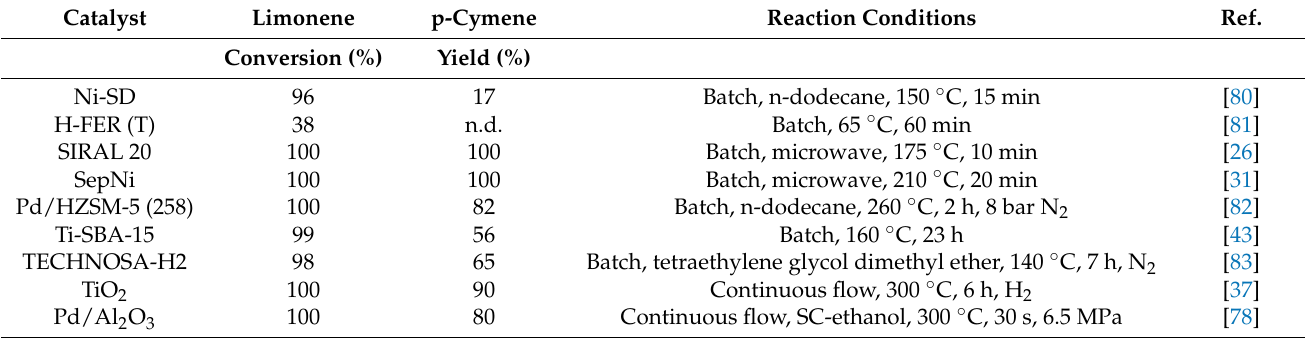
Table 2. Conversion of Limonene into p-cymene promoted by heterogeneous catalysts.